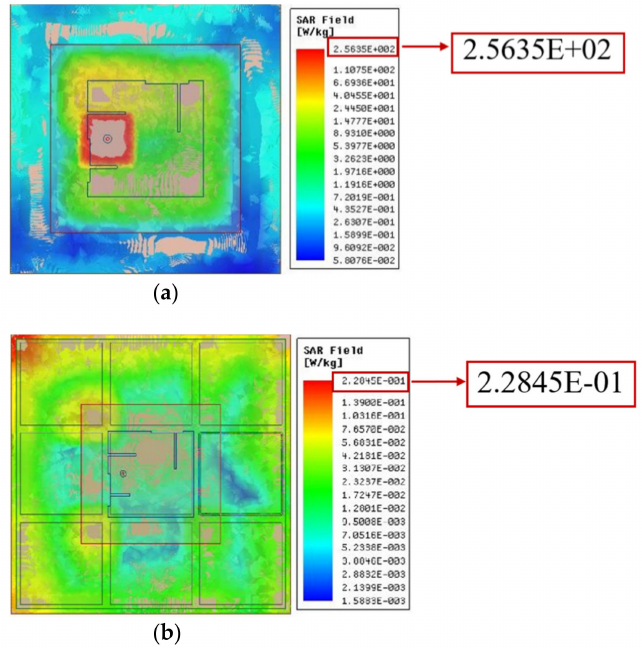
Figure 14. The simulated distribution of SAR values on human tissue of textile slotted microstrip antenna: ( a ) without an AMC, ( b ) with an